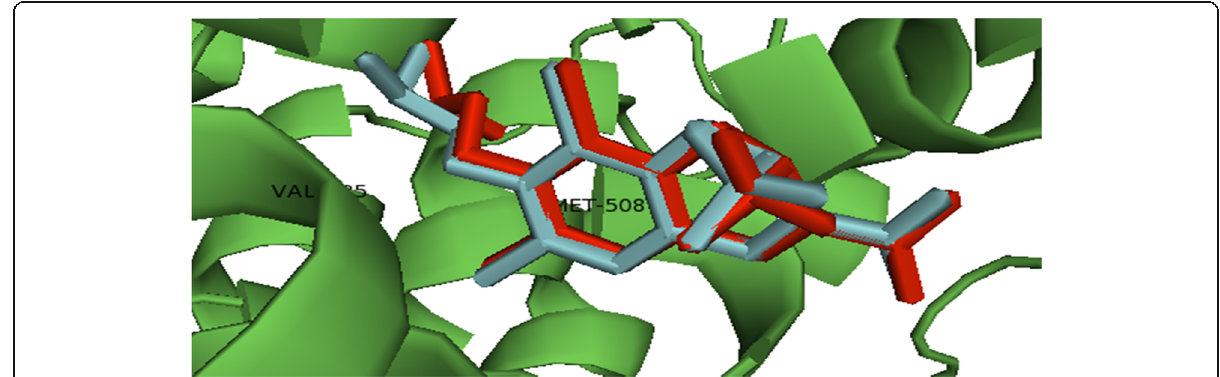
Fig. 4 The binding mode of the re-docked (cyan) and the co-crystallized, aspirin (red) within the active site of